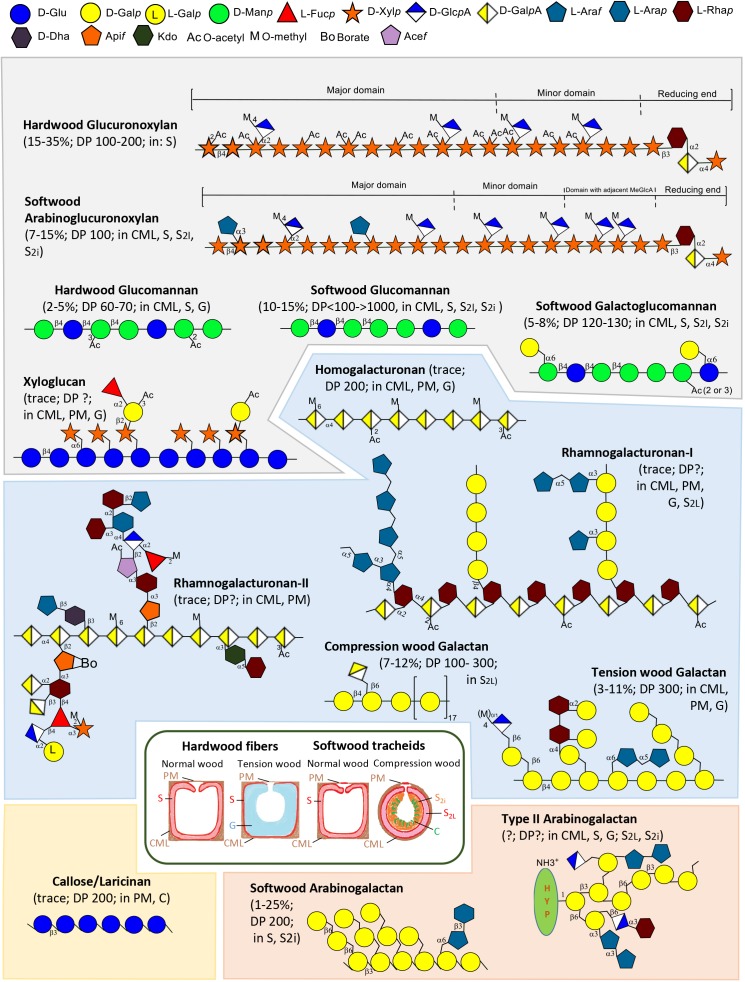
Schematic illustration of types of non-cellulosic polysaccharides of wood, including hemicelluloses (gray background), pectins (blue background), callose (yellow background) and AGs-II (orange background), and hardwood fibers and softwood tracheids (inset). Polymer structures were based on different sources: hardwood GX (Teleman, 2009; Smith et al., 2017), softwood arabinoglucuronoxylan (Teleman, 2009; Martínez-Abad et al., 2017; Smith et al., 2017), hardwood and softwood glucomannan (GM), softwood GGM, tension and compression wood galactans, callose (Teleman, 2009), xyloglucan (Carpita and McCann, 2000; Teleman, 2009), HG (Atmodjo et al., 2013), RG-I and -II (Edashige and Ishii, 1996, 1997, 1998; Atmodjo et al., 2013), AG-II (Carpita and McCann, 2000; Hijazi et al., 2014), softwood arabinogalactan (Ponder and Richards, 1997; Teleman, 2009). Polymer localization is based on the following sources: hardwood GX and mannans (Kim and Daniel, 2012; Gorshkova et al., 2015; Guedes et al., 2017), softwood arabinoglucuronoxylan (Altaner et al., 2010; Donaldson and Knox, 2012), callose (Altaner et al., 2010; Zhang et al., 2016), xyloglucan (Bourquin et al., 2002; Sandquist et al., 2010; Nishikubo et al., 2011; Donaldson and Knox, 2012; Kim and Daniel, 2013; Guedes et al., 2017), HG (Kim and Daniel, 2013), RG-I/compression wood galactan/tension wood galactan (Gorshkova et al., 2015; Zhang et al., 2016; Guedes et al., 2017), AG-II/softwood arabinogalactan (Altaner et al., 2010; Guedes et al., 2017). PM, pit membrane; CML, compound middle lamella; S, secondary wall layer (S-layer), G, gelatinous layer (G-layer); C, cavities; S2i, inner S2 layer; S2L, outer lignified S2 layer.